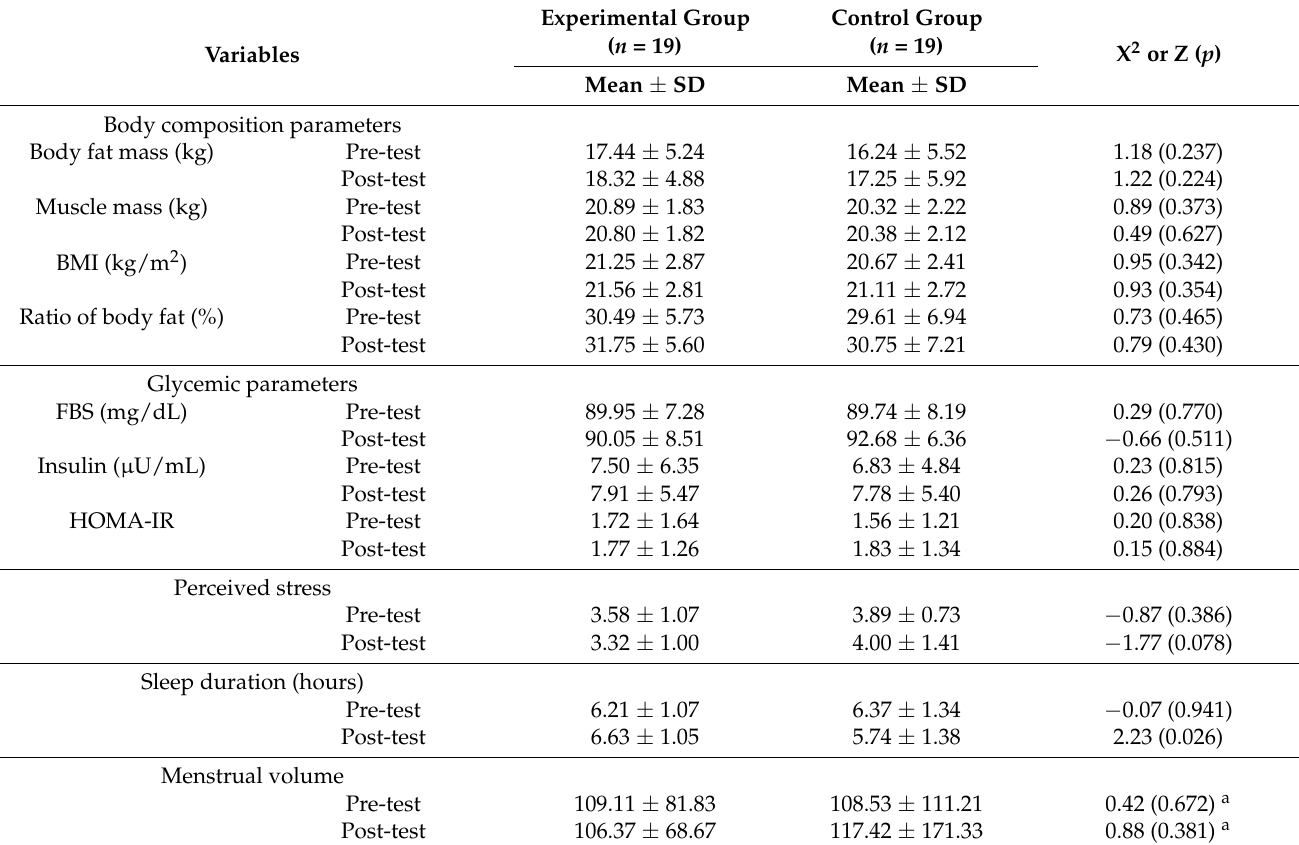
Table 4. Comparison of body composition parameters, glycemic parameters, perceived stress, sleeping duration, and menstrual volume in the experimental and control groups ( n =